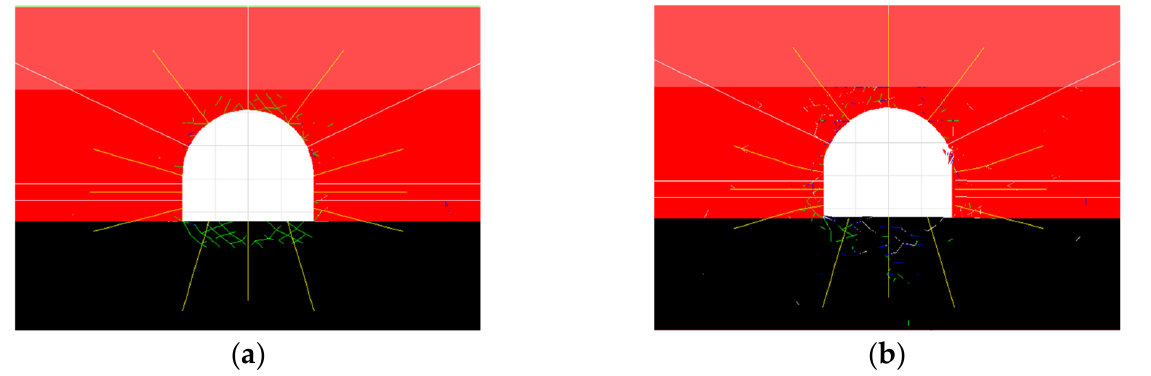
Figure 15. Average displacement of two ribs, roof, and floor of the roadway. ( a ) ribs; ( b ) roof and floor. As can be observed from Figure 16, in the initial stage, only a few shear cracks caused by instantaneous deformation appeared in the roadway surrounding rock. On the 300th day, the anchor bolts at the shoulder corners and the bottom corners of the ribs bent slightly without breakage. The ribs shared consistent damage characteristics, and only a few cracks were distributed on the roadway surface, while almost no cracks appeared in the deep surrounding rock. On the roadway floor, there were merely tensile cracks on the surface; the central block of the roof no longer moved, and the surrounding rock of the roof was relatively integrated.